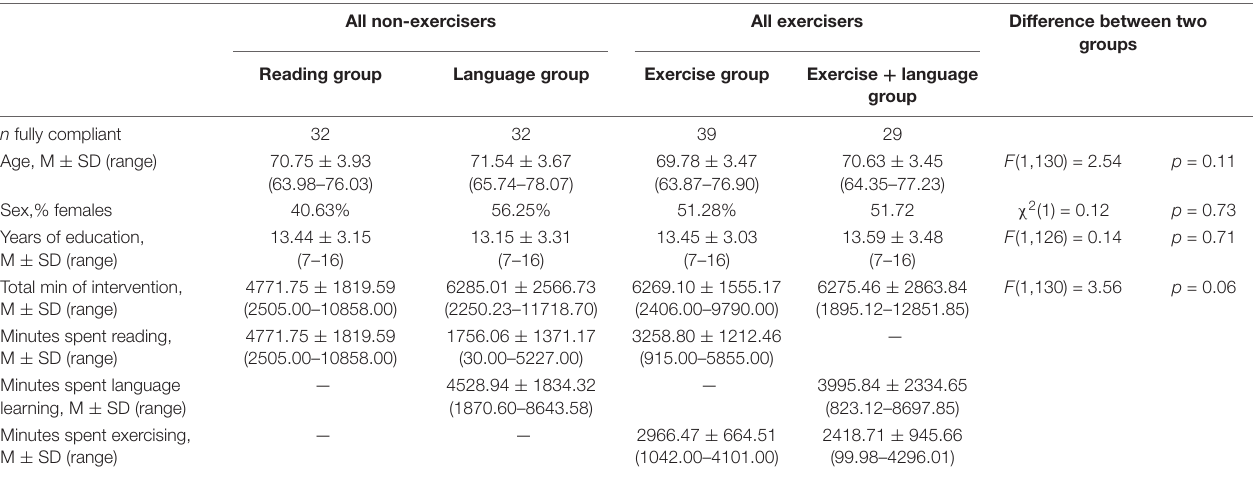
TABLE 1 | Sample descriptives and intervention